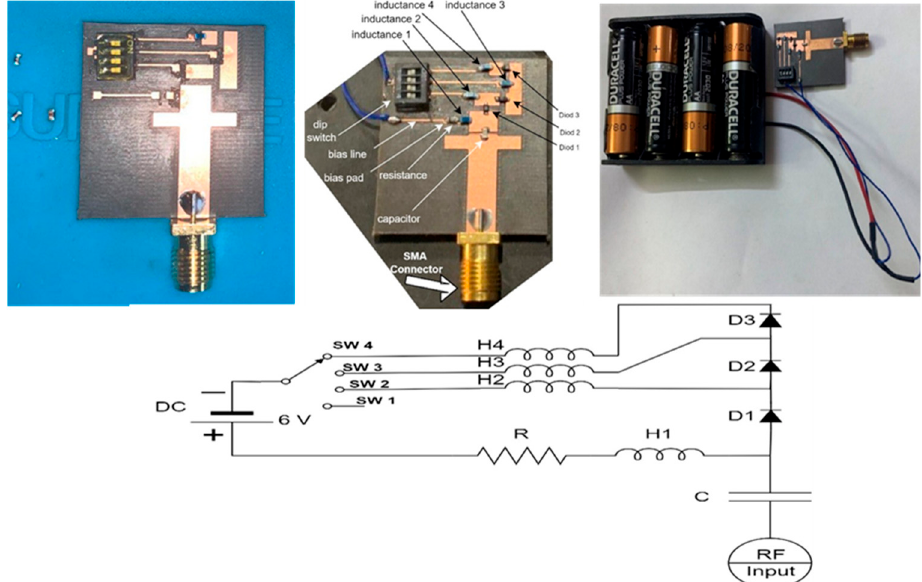
Figure 3. The fabrication of the suggested antenna and biasing circuit.